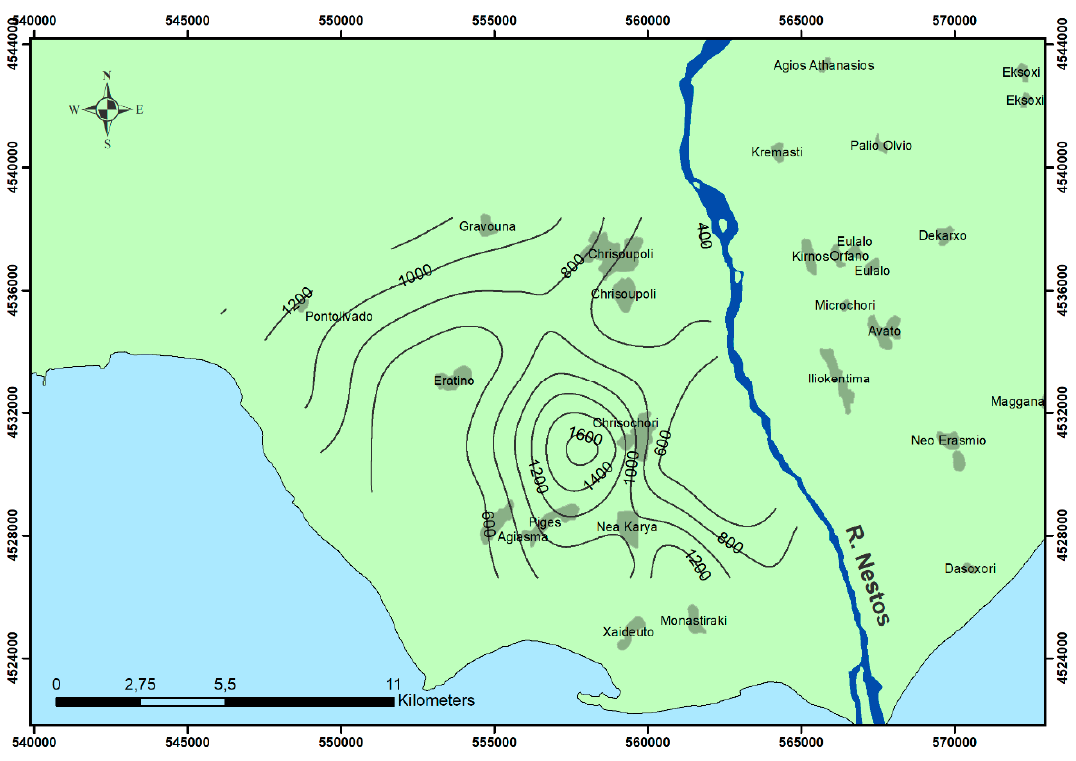
Figure 10. Electrical conductivity distribution map ( μ S/cm) of the unconfined aquifer (October 2019).